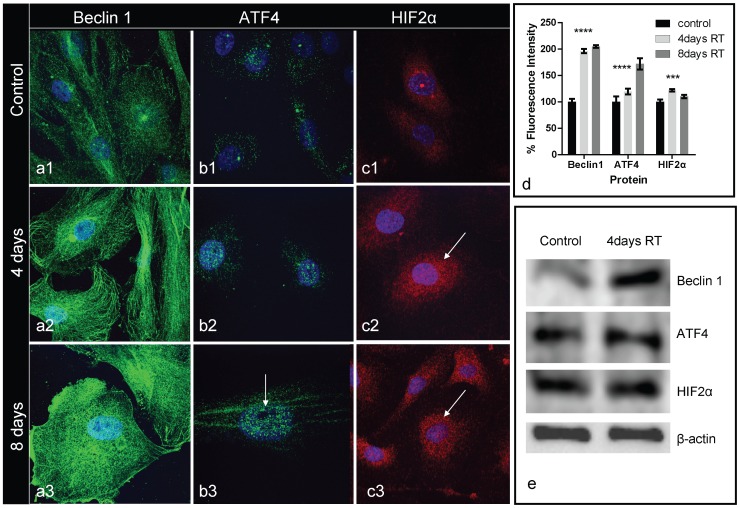
HUVEC confocal images of Beclin 1 (green) (Fig. 2a), ATF4 (green) (Fig. 2b) and HIF2α (red) (Fig. 2c).Intense accumulation of Beclin 1 was evident 4 and 8 days after irradiation (2a2, 2a3). Intense nuclear localization of ATF4 (arrows) at 4 and 8 post-irradiation days is shown in figure panel 2b, while HIF2α was also induced in the cytoplasm and nuclei (arrows) of HUVEC (figure panel 2c). Graphic presentation of fluorescent intensity of the above immunostaining is shown in Figure 1d. Figure 1e shows the western blot analysis in the pellet fraction of HUVEC.